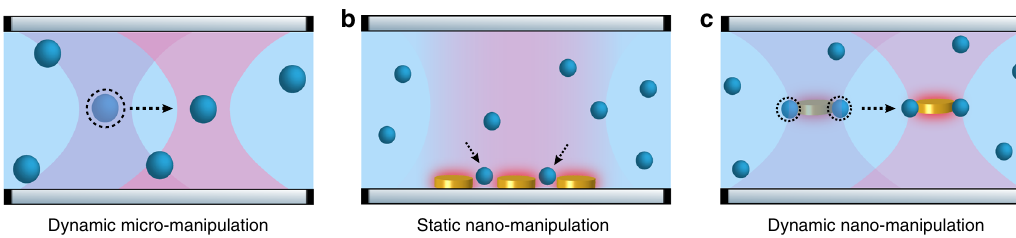
Fig. 1 Schematic illustration of the concept of ACT. a Dynamic manipulation of micro-objects with conventional optical tweezers. b Trapping of nano- objects with plasmonics based nanotweezers at prede fi ned locations. c Dynamic nanomanipulation with ACT by combining far- and near- fi eld focusing of